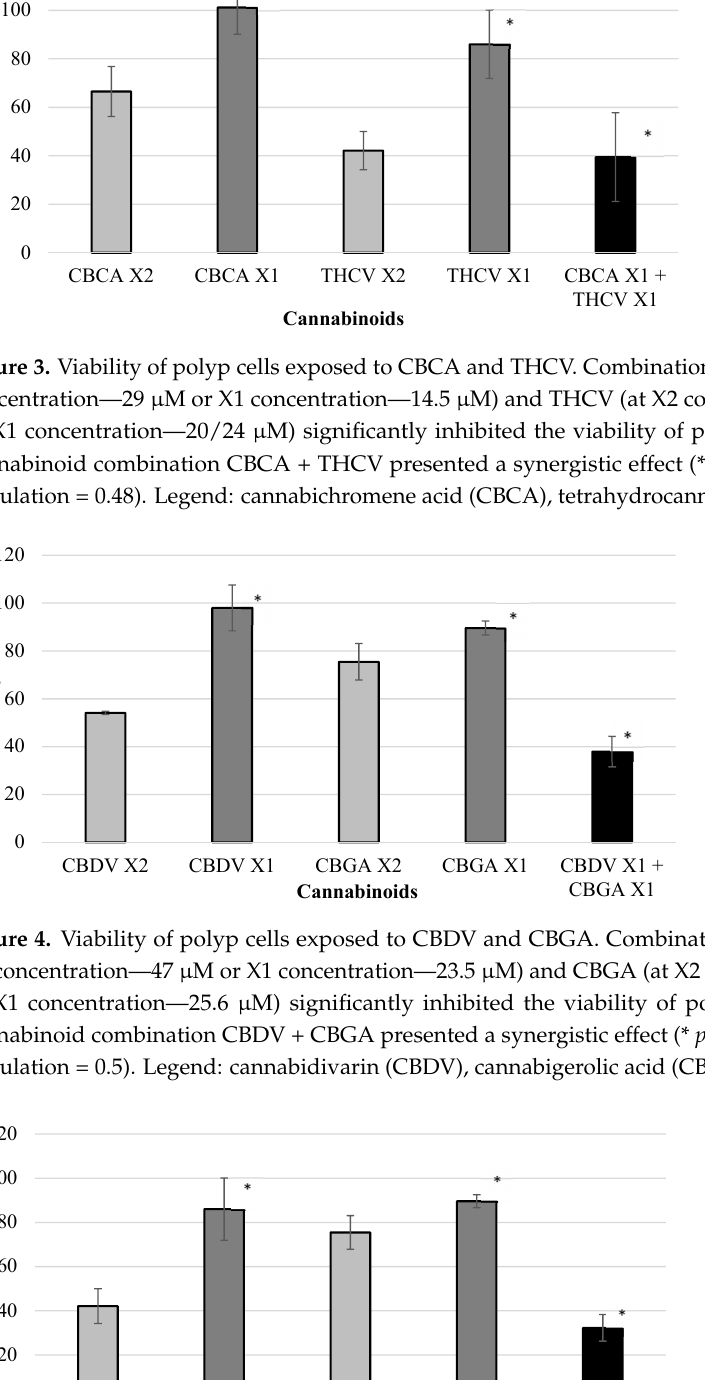
Figure 6. Viability of polyp cells exposed to THCV and CBDVA. The cannabinoid combination THCV + CBDVA showed no synergistic effect (* p > 5, Bliss equation calculation = 0.01). Legend: tetrahydrocannabivarin (THCV), cannabidivarinic acid (CBDVA).